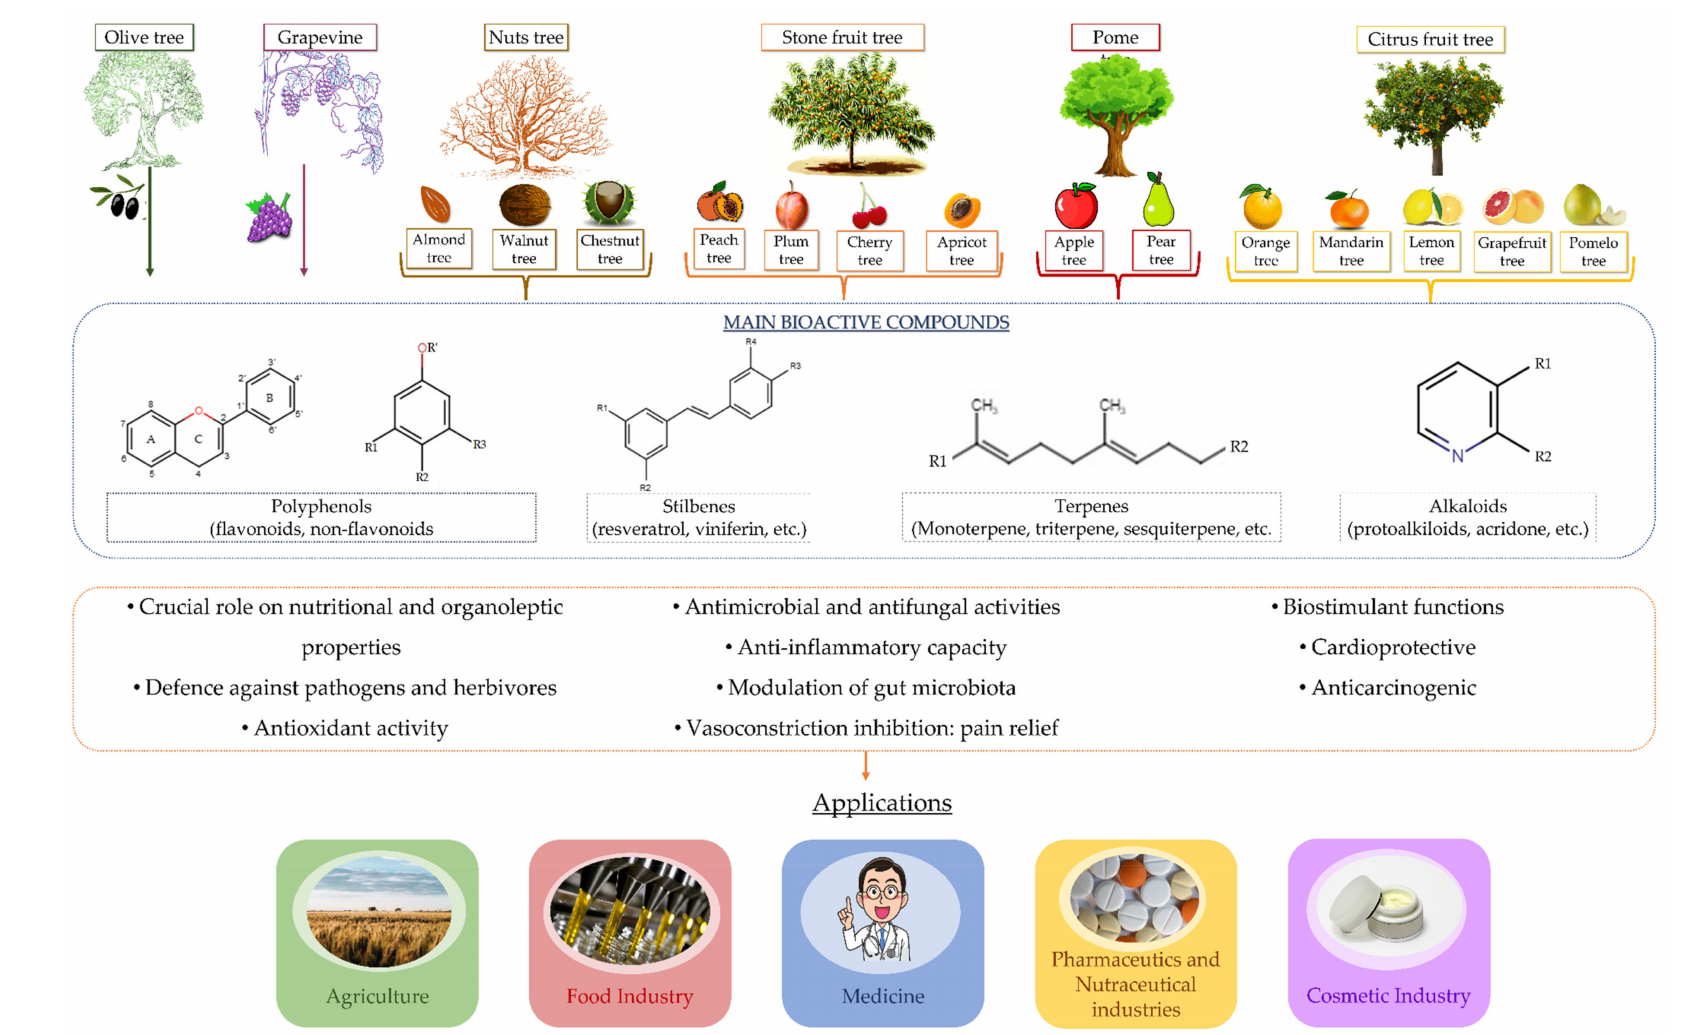
Figure 3. Bioactive compounds present in olive, grapevine, nut, stone fruit, pome fruit, and citrus fruit wood waste, main bioactive properties, and applications reviewed in the current